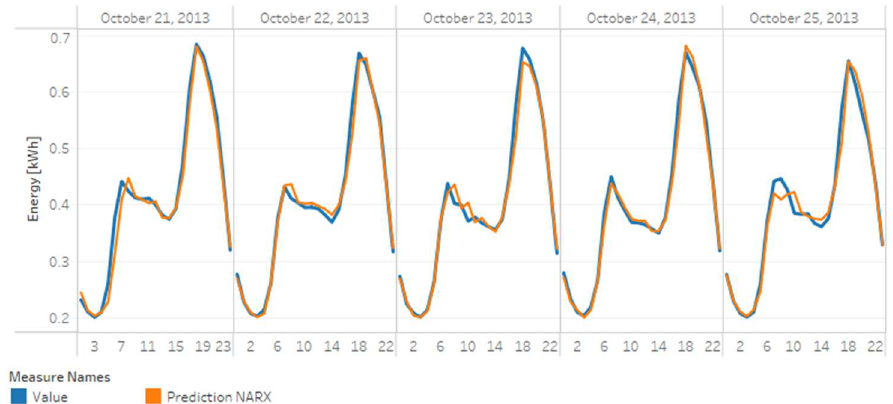
Figure 15. Electricity forecasting for meter MAC000002. Sensors 2020 , 20 , x FOR PEER REVIEW